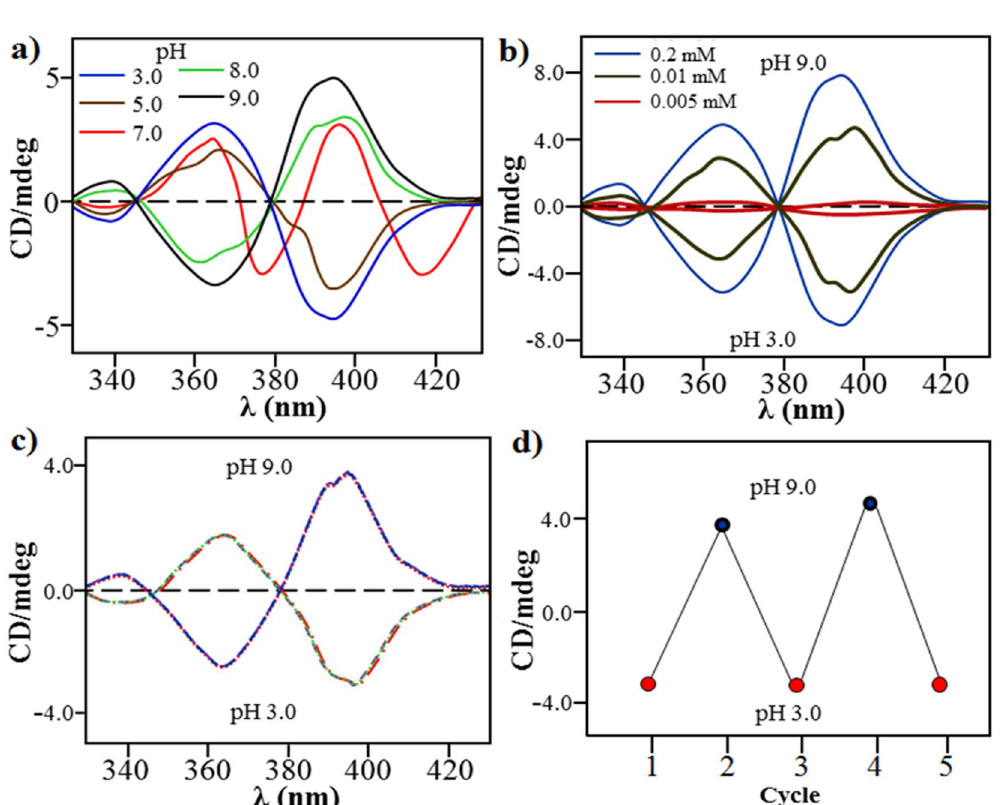
Figure 3. pH-dependent Chirality Inversion. ( a ) Circular dichroism (CD) spectra of NDI-L-Glu ( 1 ) (c = 10 − 5 M) at 3 to 9 pH range, and ( b ) the CD spectra of 0.5, 1.0 and 1.5 mM solution concentrations of 1 at pH 3 and 9. ( c ) CD spectra of 1 solution with cyclic switching between pH 3 and 9, and ( d ) changes in the CD signal intensity at 362 nm of NDI-L-Glu ( 1 ) in Robinson-Britton buffer solution upon pH changes between acidic (pH = 3.0) and alkaline (pH = 9.0) conditions,